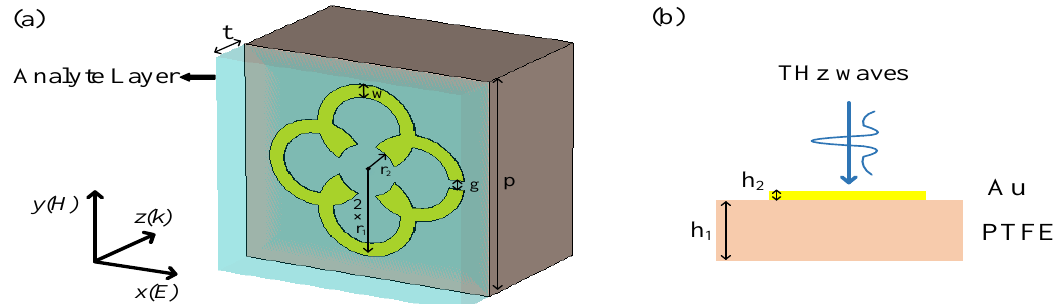
Figure 1. ( a ) Schematic diagram of the proposed SMSRR; ( b ) cross-sectional view of the